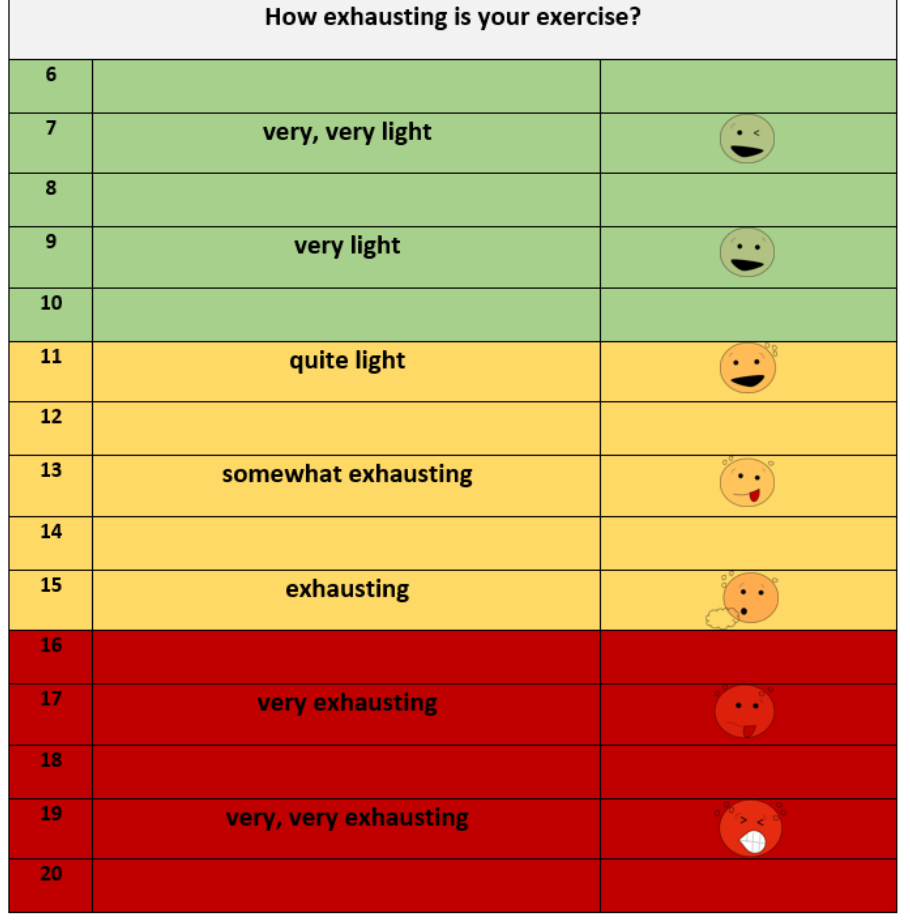
Figure 2. Scale for rating of perceived exertion (RPE scale, modified version of the BORG scale) (Borg 1962). The scale shows a range from 6 to 20. Participants were asked to estimate their subjectively perceived rate of exertion. For children and adolescents, the scale was modified by adding faces that visually reflect the level of exertion.